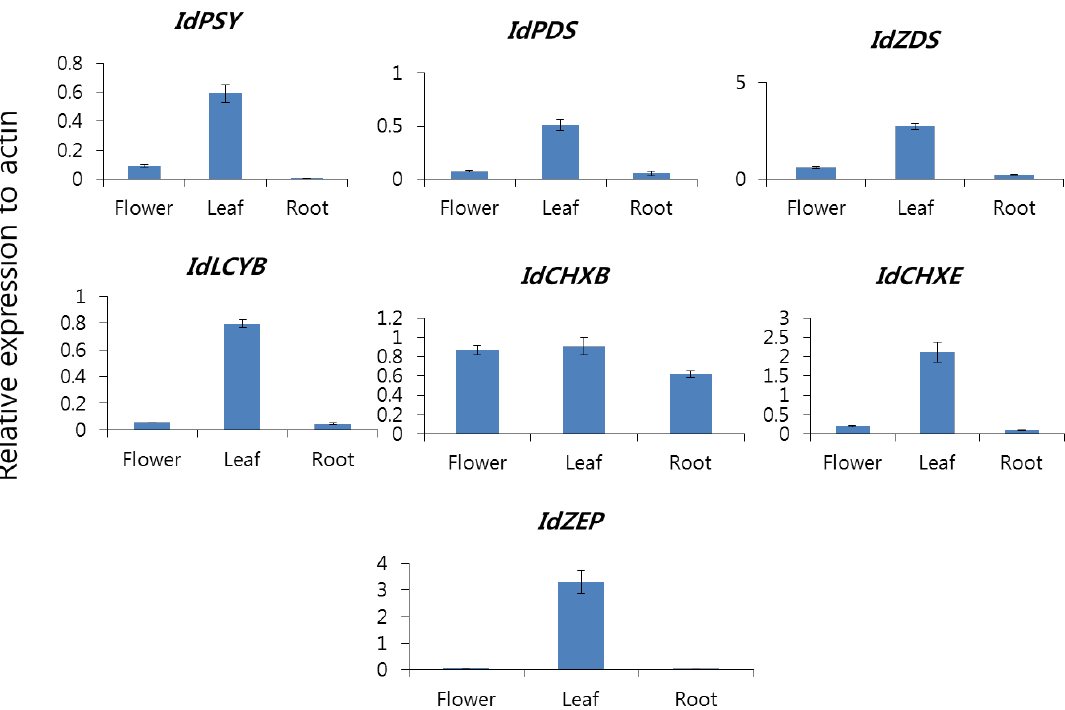
Figure 1. Transcript levels of IdPSYs , IdPDSs IdZDSs , IdLCYBs , IdCHXBs , IdCHXE , and IdZEPs in the flower, leaf, and root of I. dentata . The height of the bar and the error bars indicate the mean and standard error, respectively, that was derived from three independent experiments. At least three different samples were used for an individual experiment.